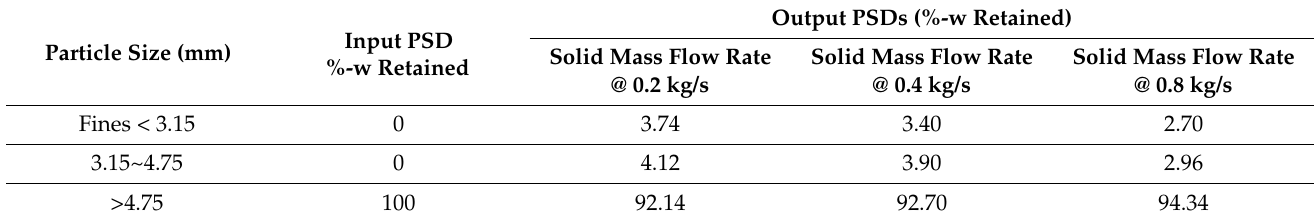
Table 10. Degradation of aged pellets at an air flow rate of 0.30 kg/s with bends in proximity.